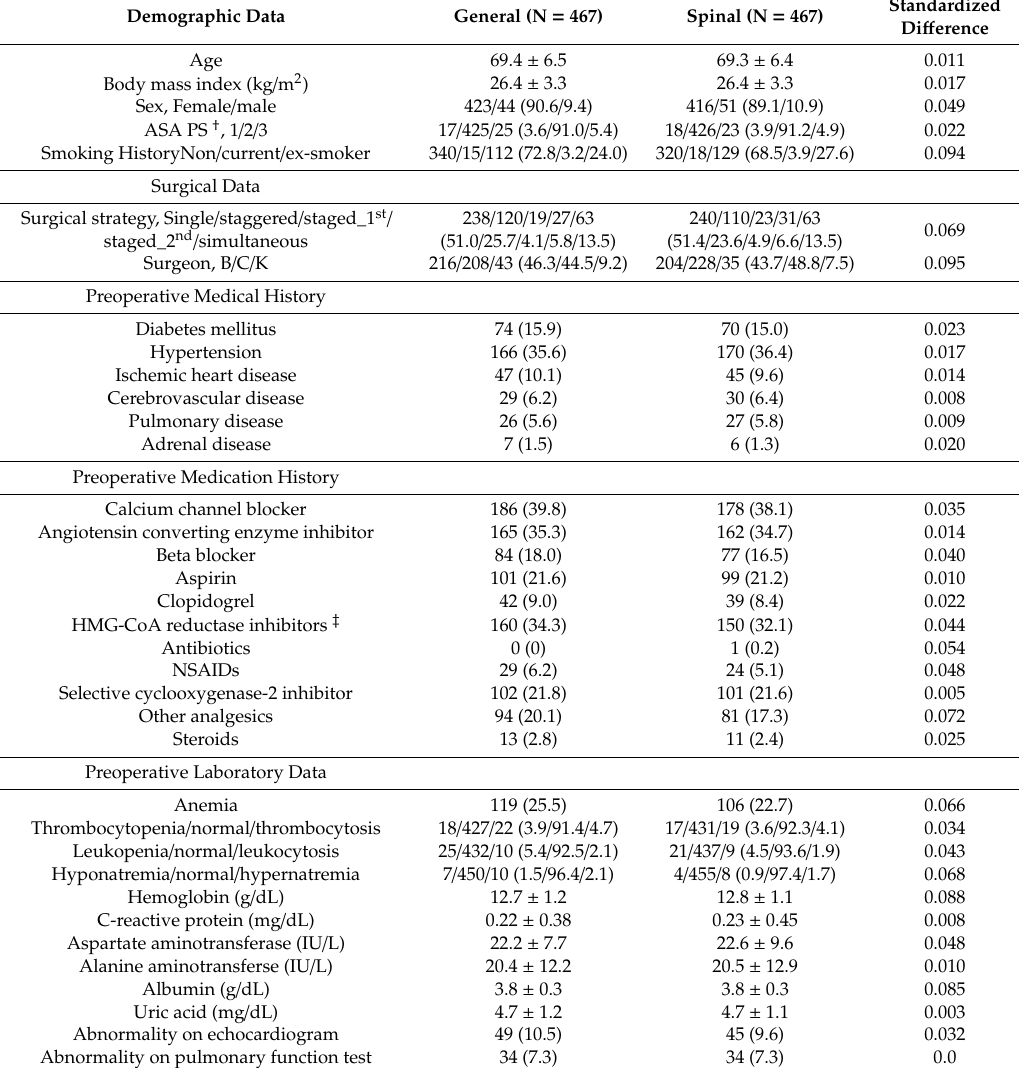
Table 2. Baseline characteristics of the patients included in the propensity score matched